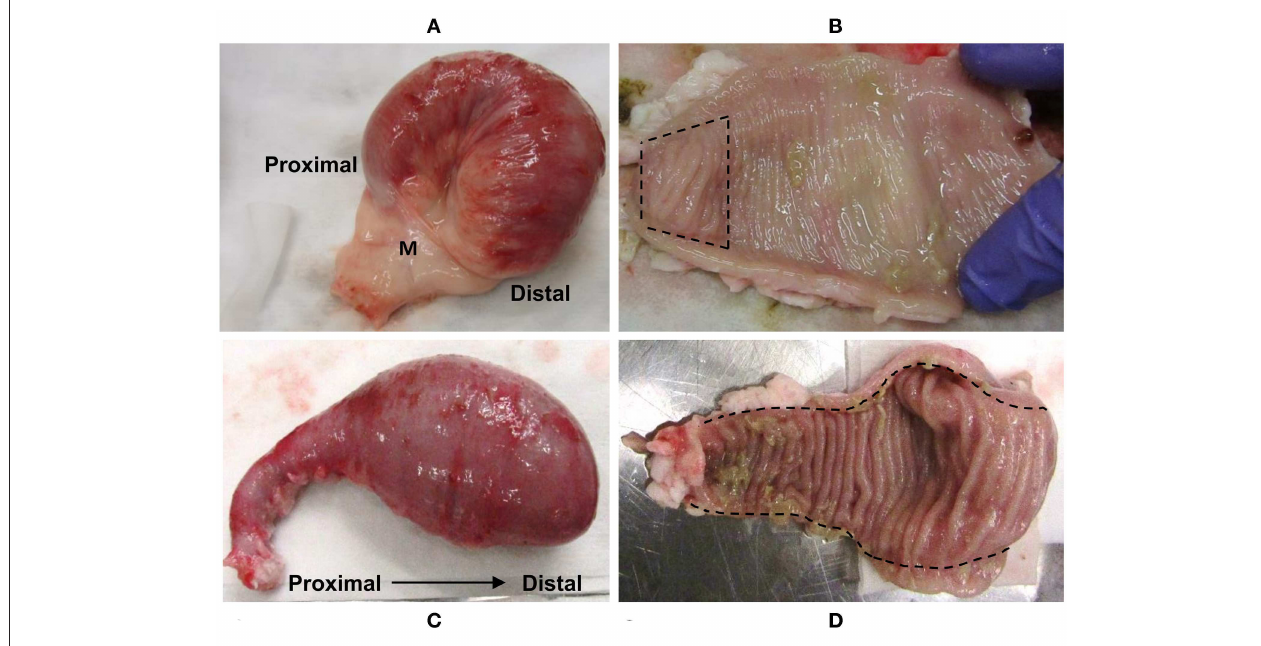
FIGURE 1 | Intestinal segments removed from the abdomen at 12 months post-surgery. Representative images of the serosal surface of (A) mid-jejunum and (C) terminal jejunal segments. (B) Mid-jejunal segment opened along the mesenteric attachment and luminal contents removed to show mucosal surface with a DPP (between the hash marks). (D) Terminal jejunal segment opened along mesenteric attachment and luminal contents removed to reveal the CPP running the entire length of the segment. M,